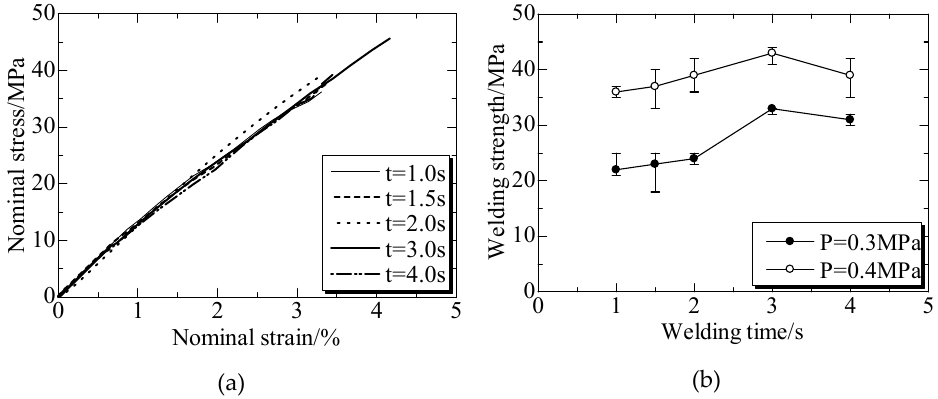
Figure 10. Welded strengths at different welding times. ( a ) Nominal stresses and strain at different welding times under welding pressure of 0.4 MPa; ( b ) Welded strengths at different welding times. Adapted from Reference [149].